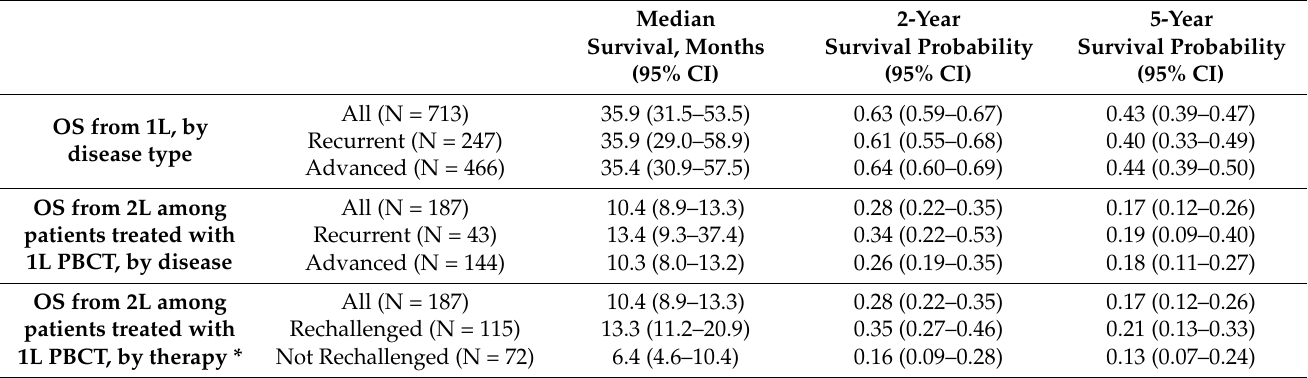
Table 3. OS after first- or second-line treatment in EC